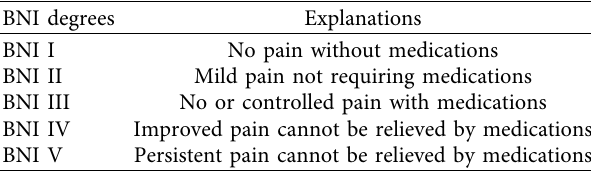
Table 1: Barrow Neurological Institute pain inventory.